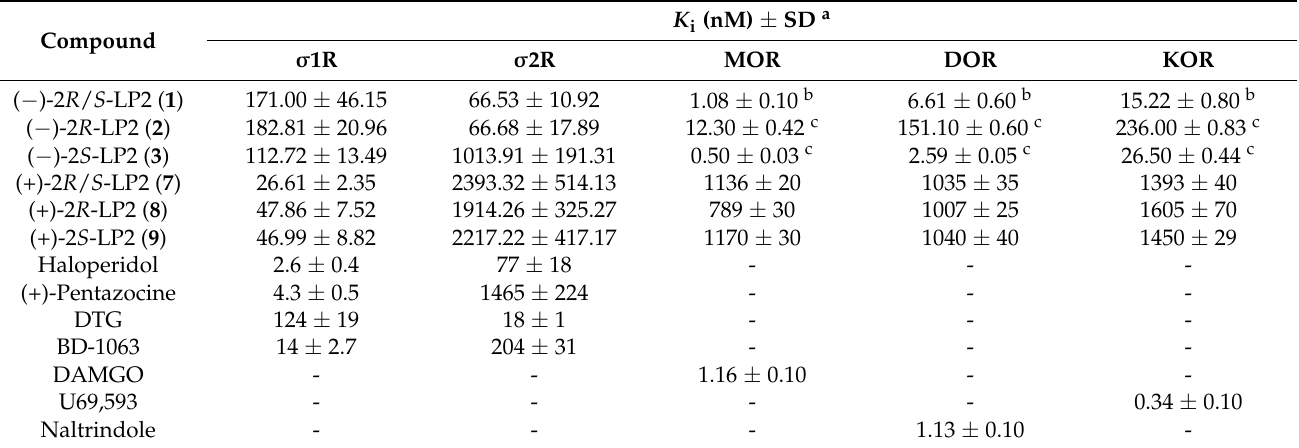
Table 1. σ 1R, σ 2R, and opioid receptors binding assays for compounds 1 – 3 and 7 – 9